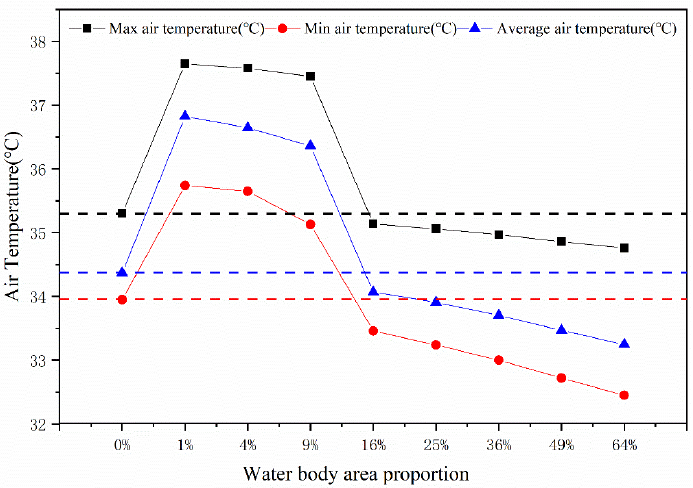
Figure 1. Maximum, minimum, and average temperatures at 14:00.